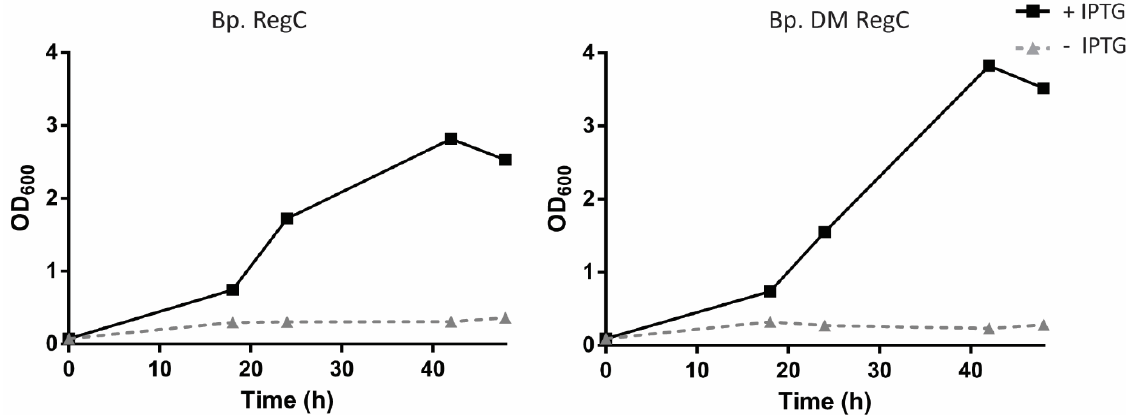
Figure 1. Growth of B. pertussis strains with regulatable lpxC in the presence or absence of 1 mM IPTG. Growth curves of Bp. RegC ( left panel ) and Bp. DM RegC ( right panel ) were measured at OD 600 for 48 h in the presence or absence of IPTG. Each graph shows values of a single experiment.